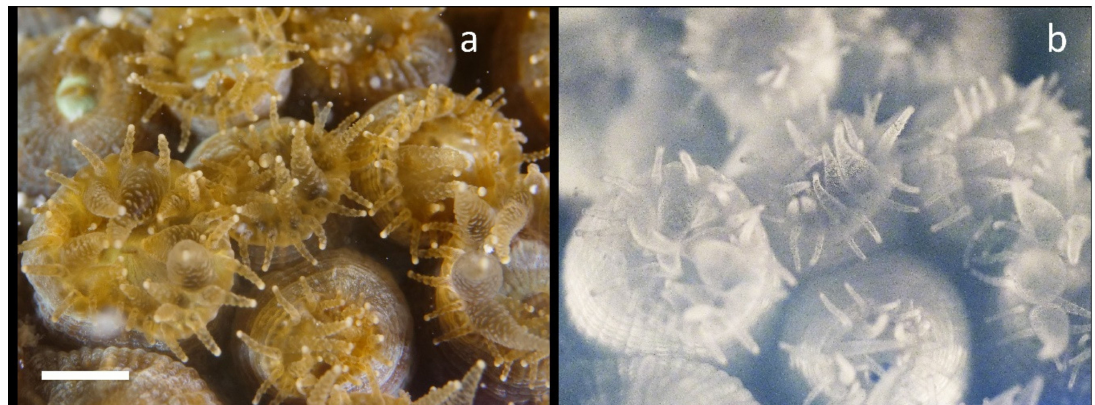
Figure 3. Nighttime in situ NIR imaging of chlorophyll fluorescence from Montastraea cavernosa . ( a ) Visible macro image shows that most polyps are partially extended. ( b ) NIR fluorescence image shows punctate fluorescence within some of the larger polyps, and brighter signals from the mesentery tissue with both radial and circular striations. The scale bar in the visible image is about 10 mm.